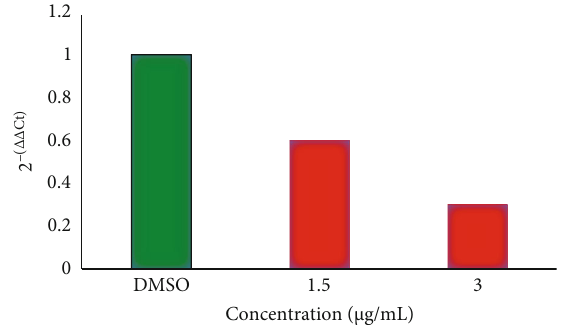
Figure 3: E ff ect of di ff erent concentrations of essential oil of D. ammoniacum oleo-gum resin on caspase-9 activity in A549 cells. Caspase-9 activity was measured based on the RT-PCR reaction, and the data were expressed as relative fold gene expression. The results are expressed as 2 -( ΔΔ Ct) of three separate experiments ( n = 3 ).